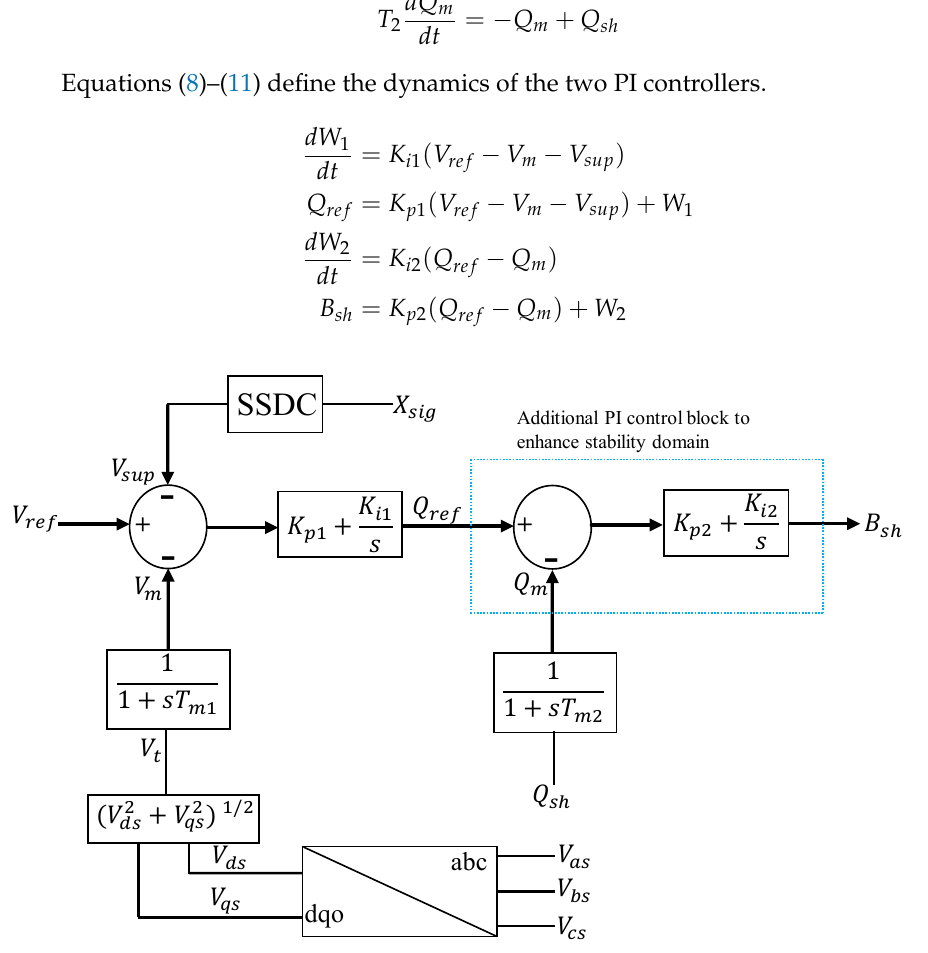
Figure 2. Block diagram of voltage regulator for the